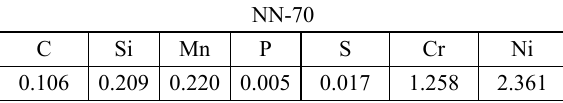
Table 1. Chemical composition of NN-70 (% wt)